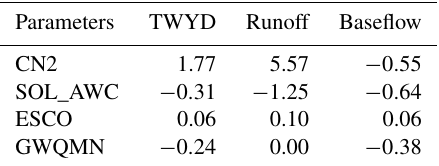
Table 2. Relative sensitivity values for all tested SWAT input pa-